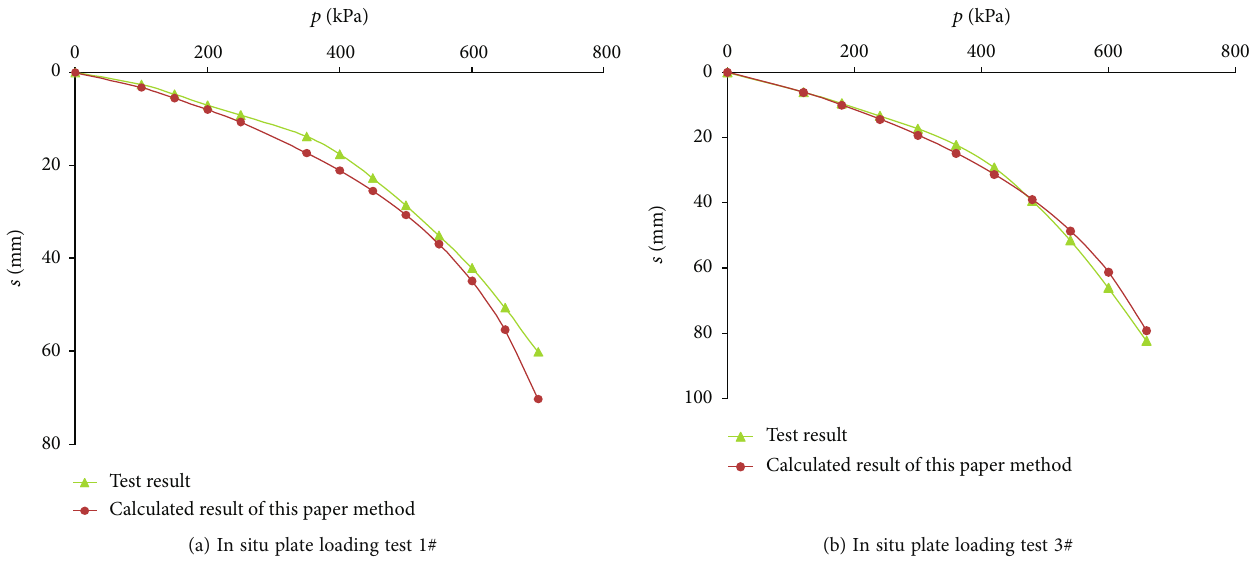
Figure 4: Comparison of calculated results of the nonlinear deformation modulus method and in situ test results. Table 3: Calculated parameters of the variable modulus constitutive